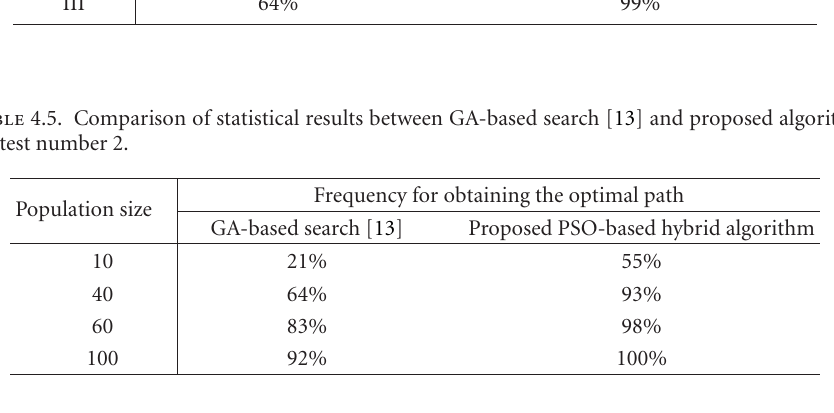
Table 4 . 6 . Comparison of statistical results between GA-based search [13] and proposed algorithm for test number 3. Number of